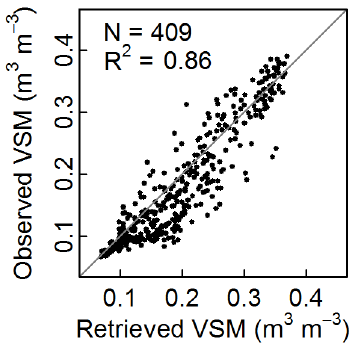
Figure 3. Scatter plot of daily mean in situ VSM observations ( N = 409) at a depth of 5cm vs. GNSS VSM retrievals (from both L2C and L5) for the whole experimental period from 1 August 2015 to 6 October